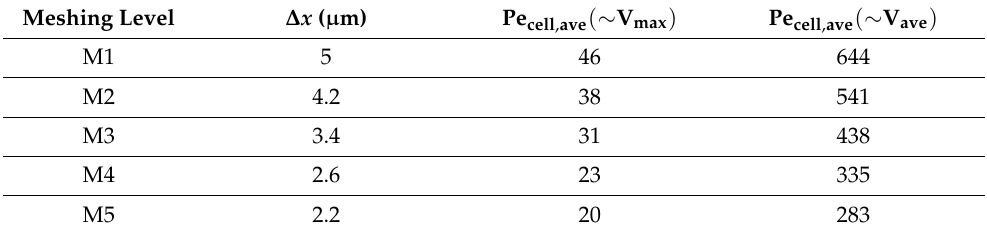
Table 2. Influence of meshing on Pe cell,ave and Pe cell,max .